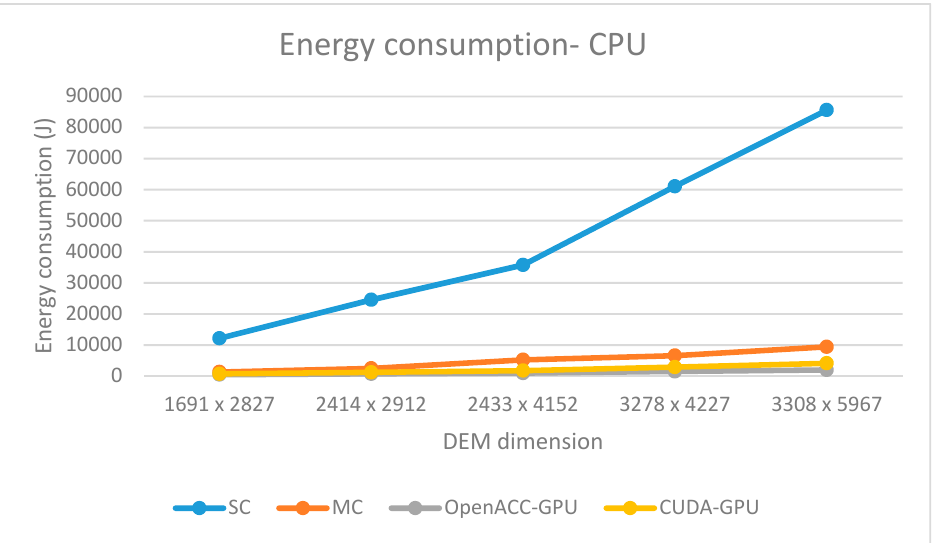
Figure 10. Energy consumption CPU ‐ Intel Xeon E5 ‐ 2620 v4 @ 2.10GHz.